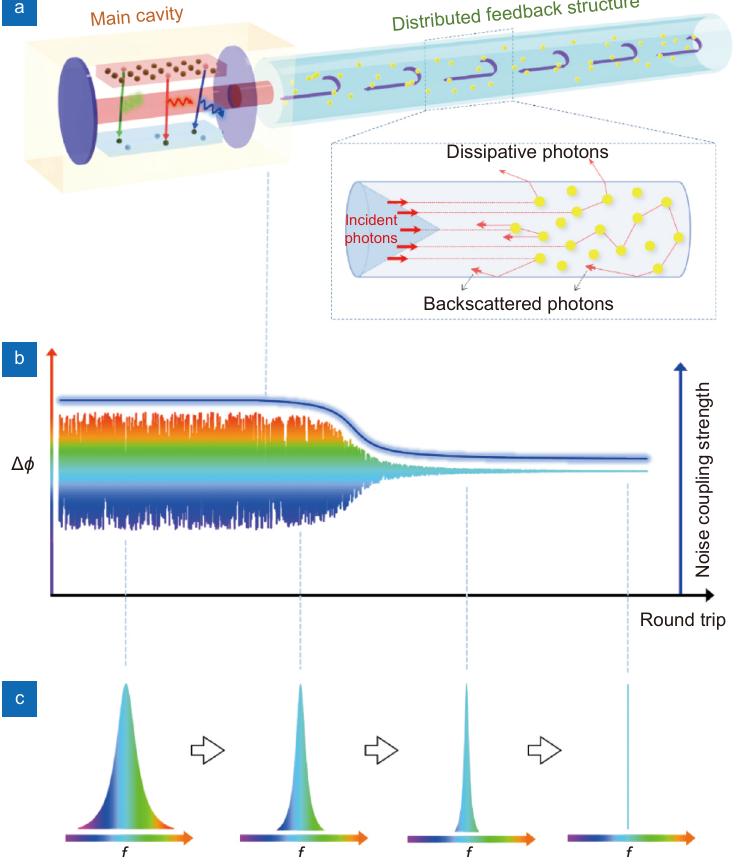
Fig. 1 | Principle of laser spectral purification based on distributed weak perturbation. ( a ) A novel laser configuration. ( b ) Evolution of laser phase fluctuation and noise coupling strength with different round trips. ( c ) Spectral distribution at different noise